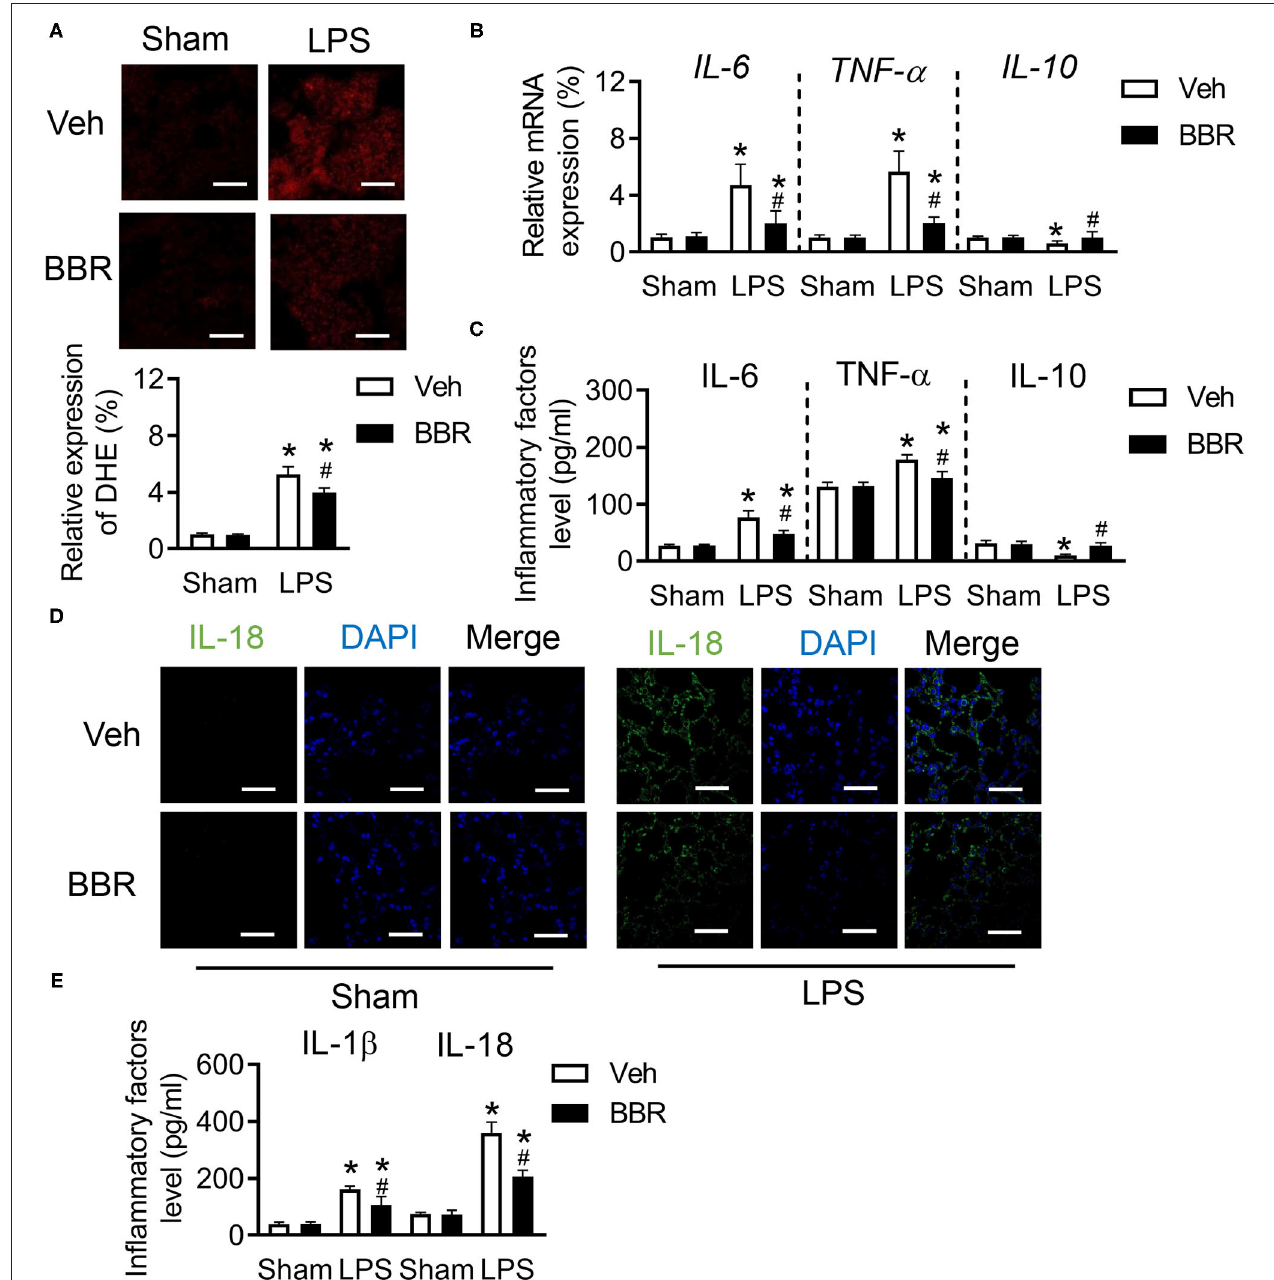
FIGURE 2 | Berberine inhibited the inflammatory cytokines in C57BL/6 mice with ALI. (A) The expression of reactive oxygen species (ROS) in pulmonary section and its quantification (down), n = 3, scale bar = 20 µ m. (B) The messager RNA (mRNA) expression of IL-6 , TNF- α , and IL-10 in lung tissue, n = 8. (C) The concentration of IL-6, TNF- α , and IL-10 in lung tissue, n = 8. (D) The expression of IL-18 in lung section, n = 3, bar = 20 µ m. (E) The concentration of IL-18 and IL-1 β in lung tissue, n = 8. Data were expressed as mean ± SD. Statistical significance is indicated as * P < 0.05 vs. the sham + vehicle groups, # P < 0.05 vs. the LPS + vehicle